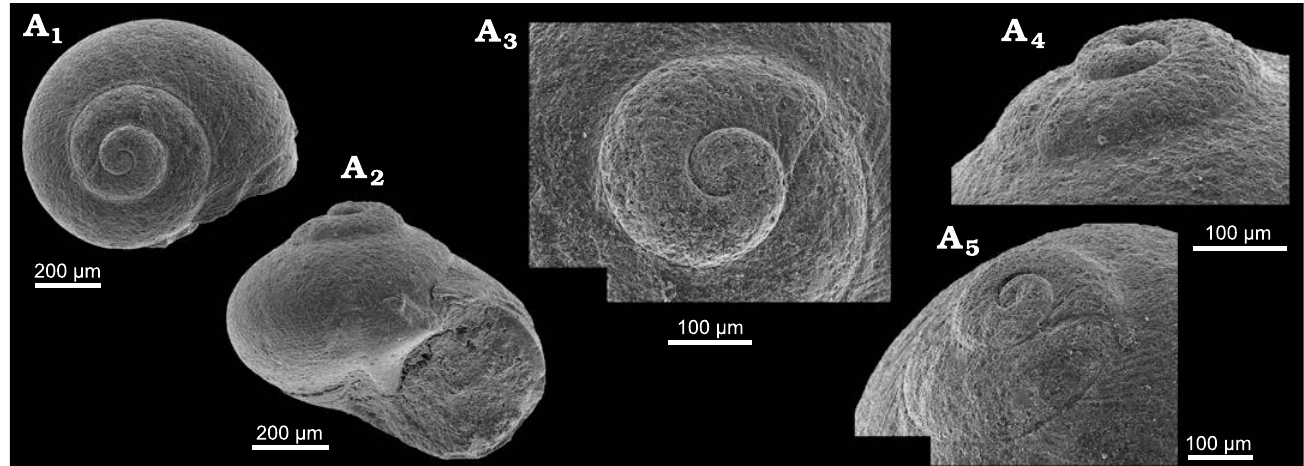
Fig. 22. Cornirostrid gastropod Bandellina compacta Nützel and Hausmann sp. nov. from Lago Antorno, northern Italy, Cassian Formation, Carnian, Upper Triassic. Holotype PZO 12840, in apical (A 1 ) and apertural (A 2 ) views; heterostrophic protoconch, in apical (A 3 ), lateral (A 4 ), and oblique lateral (A 5 )